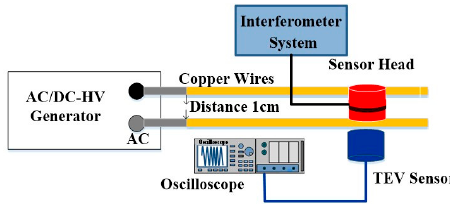
Figure 6. Experimental setup of the partial discharge of copper wires.